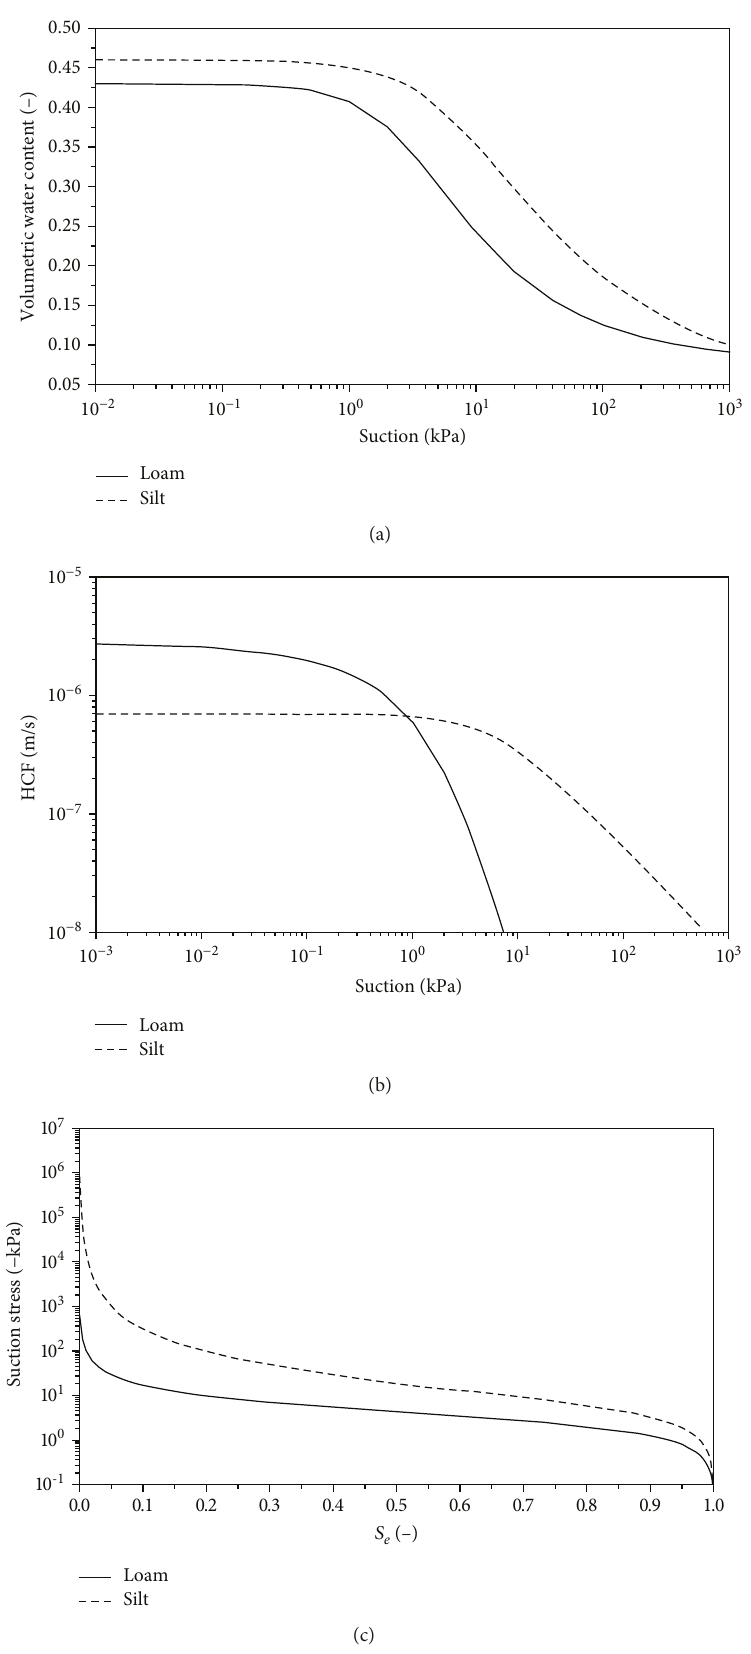
Figure 4: Hydraulic properties of loam soil and silt soil: (a) SWRC; (b) HCF; (c)